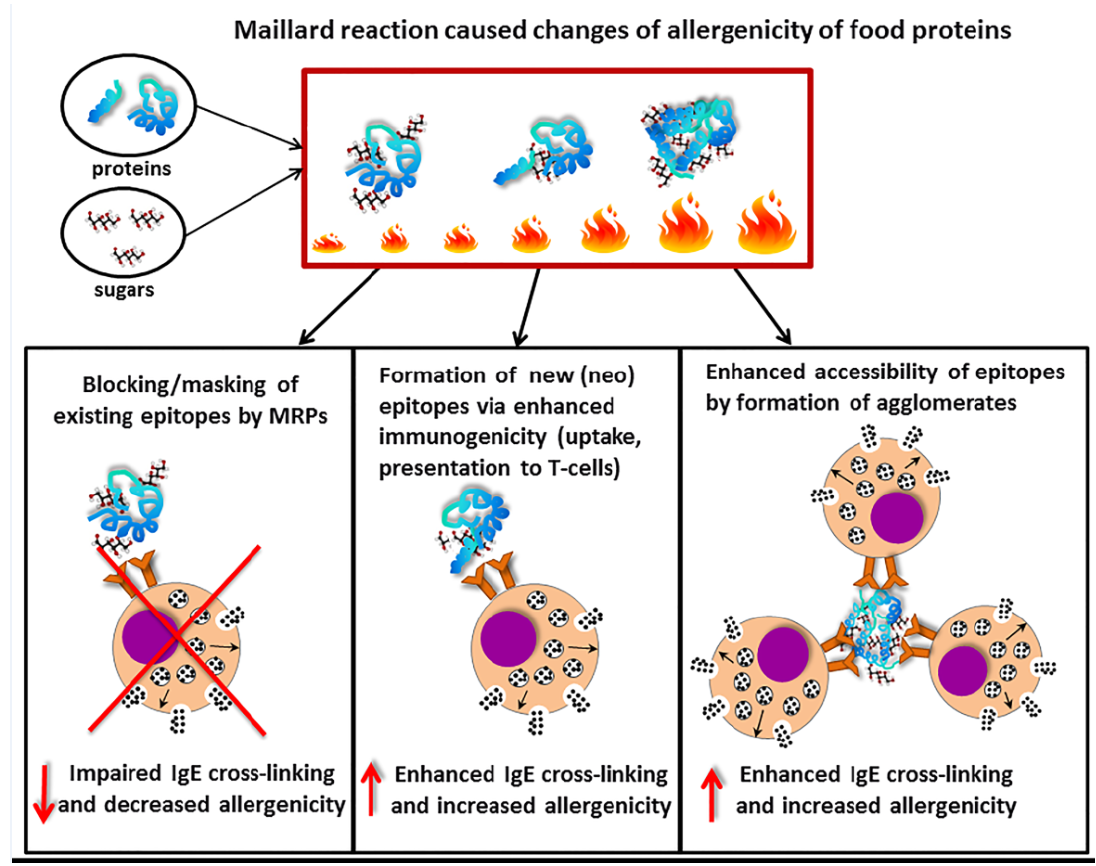
Figure 3. Modulation of allergenicity of food proteins by the Maillard reaction. Upon food processing using heating, reducing sugars will react with primary amino groups on amino acids from allergen proteins to result in Maillard reaction products (MRP). Consequently, these MRP may block epitopes thereby preventing IgE binding and crosslinking, and subsequent mediator release. This results in reduced allergenicity of the altered food allergens. Alternatively, MRP may lead to the exposure of neo ‐ epitopes leading to enhanced uptake by antigen ‐ presenting cells and exposure to specific T ‐ cells and this enhanced possibility for IgE cross ‐ linking may lead to enhanced allergenicity. Lastly, MRP may lead to the formation of agglomerates of allergen molecules resulting into enhanced IgE cross ‐ linking and increased allergenicity. The ratio between these several possibilities determines the final outcome of the mediator release capacity of the MRP altered food allergens.